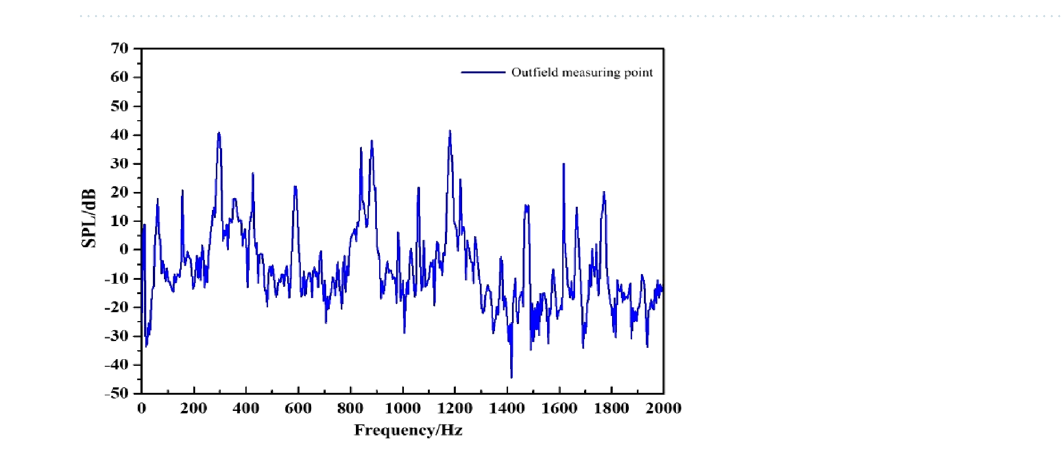
Figure 16. Directivity distribution of outfield noise by fluid excitation.